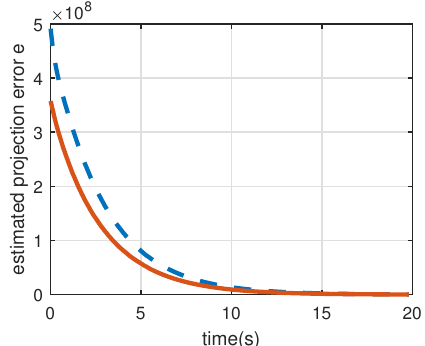
Figure 9 is the time evolution of estimated projection errors. The adaptive rule contin- uously updates the parameters in the negative gradient direction of e ( t ) , so the estimated projection errors can be reduced due to the parameter estimation.